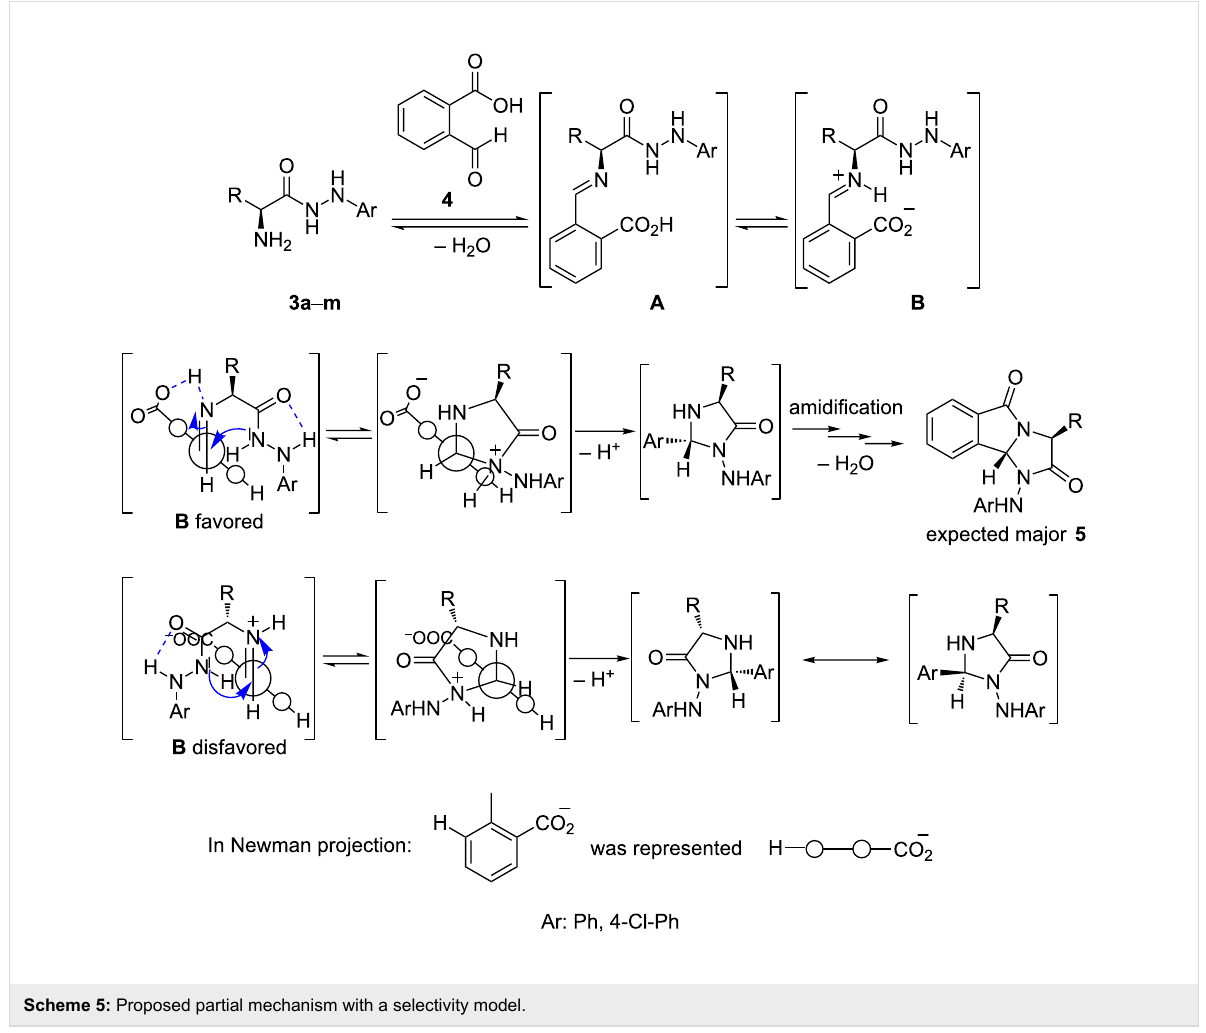
Scheme 5: Proposed partial mechanism with a selectivity model.